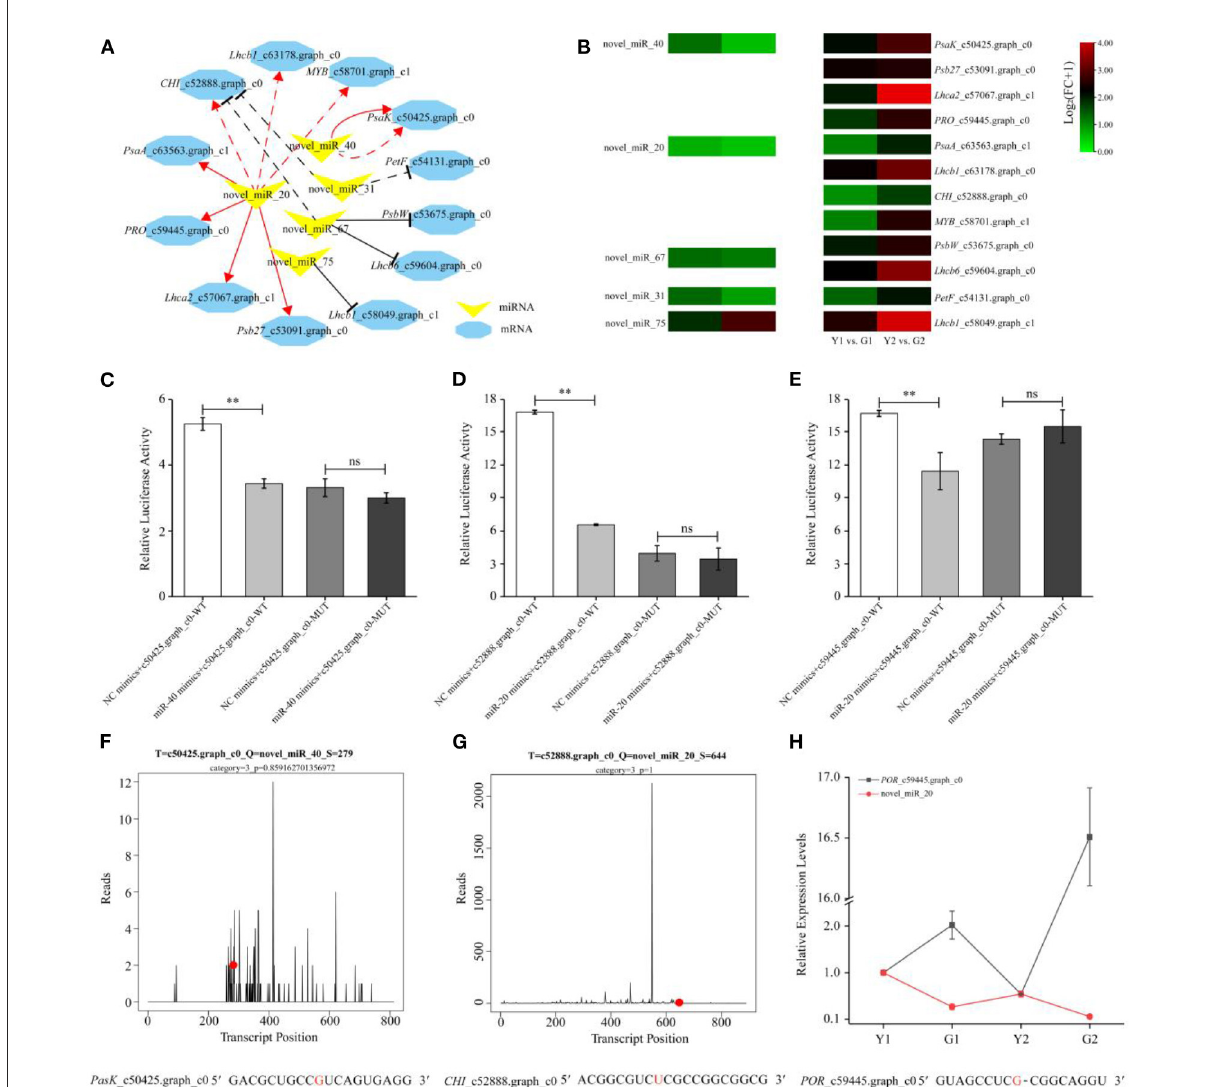
FIGURE9 Expression profile and validation of key miRNA-mRNA interaction pairs. (A) A representative regulation module related to photosynthesis and pigment metabolism formed by five DEMs (yellow V-shape) and 12 DEGs (blue hexagon). The red solid and dashed lines indicate coherent miRNA-mRNA pairs via in silico and degradome analyses, respectively. The black solid and dashed lines indicate non-coherent miRNA-mRNA pairs via in silico and degradome analyses, respectively. (B) Expression heatmaps of selected pairs of DEMs and their target DEGs. The heatmap on left and right respectively, indicated the expression of DEMs and DEGs. (C–E) Verification of three miRNA-mRNA correlation pairs using a dual-luciferase reporter assay. Data is presented as the mean ± standard deviation. Statistical analyses were performed by student’s t -test, **: p < 0.01 and ns: p > 0.05. (F, G) Nucleotide cleavage positions of novel_miR_40- PasK _c50425.graph_c0, and novel_miR_20- CHI _c52888.graph_c0 pairs were validated by degradome sequencing. The red dots represent the cleavage